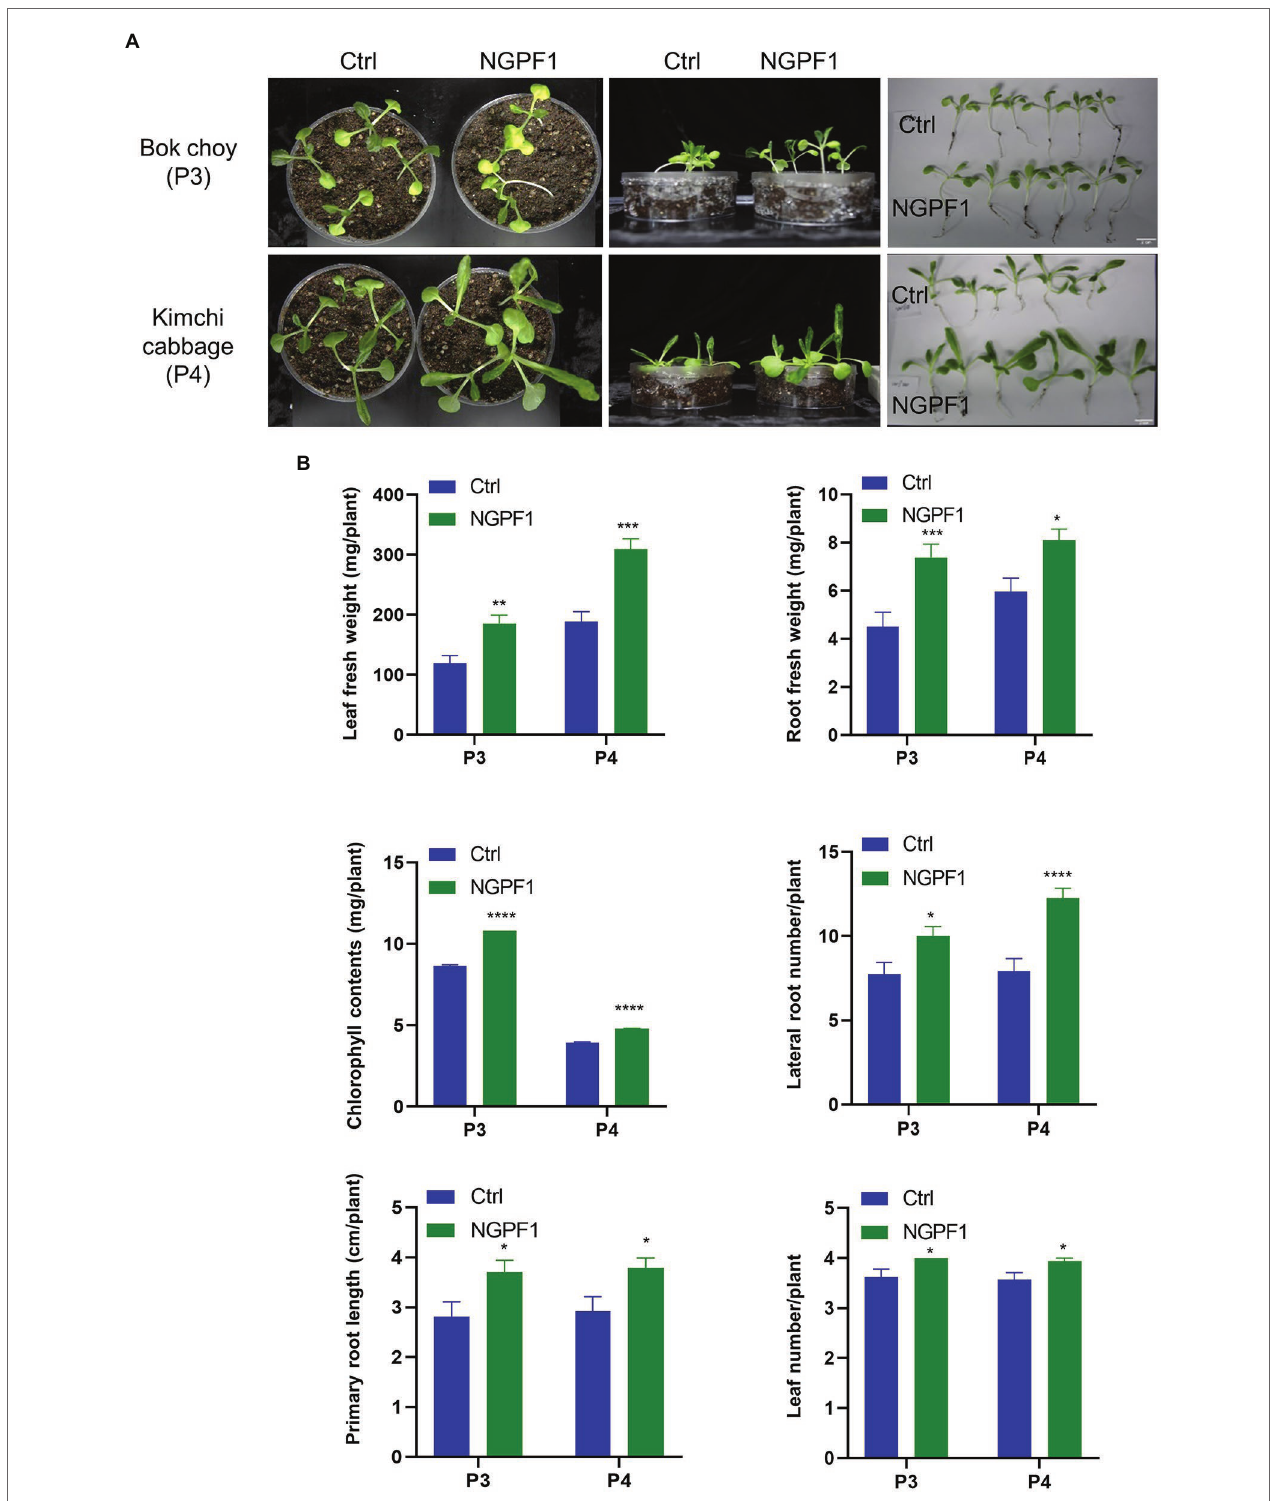
FIGURE 3 | Effects of VOCs of C. halotolerans NGPF1 on plant growth enhancement in soils. (A) Growth promotion of bok choy and kimchi cabbage with VOCs of C. halotolerans NGPF1 in soils. (B) Quantification of leaf fresh weight, leaf number, chlorophyll contents, root fresh weight, lateral root number, and root length after exposure to fungal VOCs. Error bars indicate the standard deviation of the mean ( n = 15). Asterisks indicate a statistically significant difference between control (ctrl, no treatment) and NGPF1 treatment (two-way ANOVA, * p < 0.05, ** p < 0.01, *** p < 0.001, and **** p < 0.0001). Experiments were repeated twice with similar